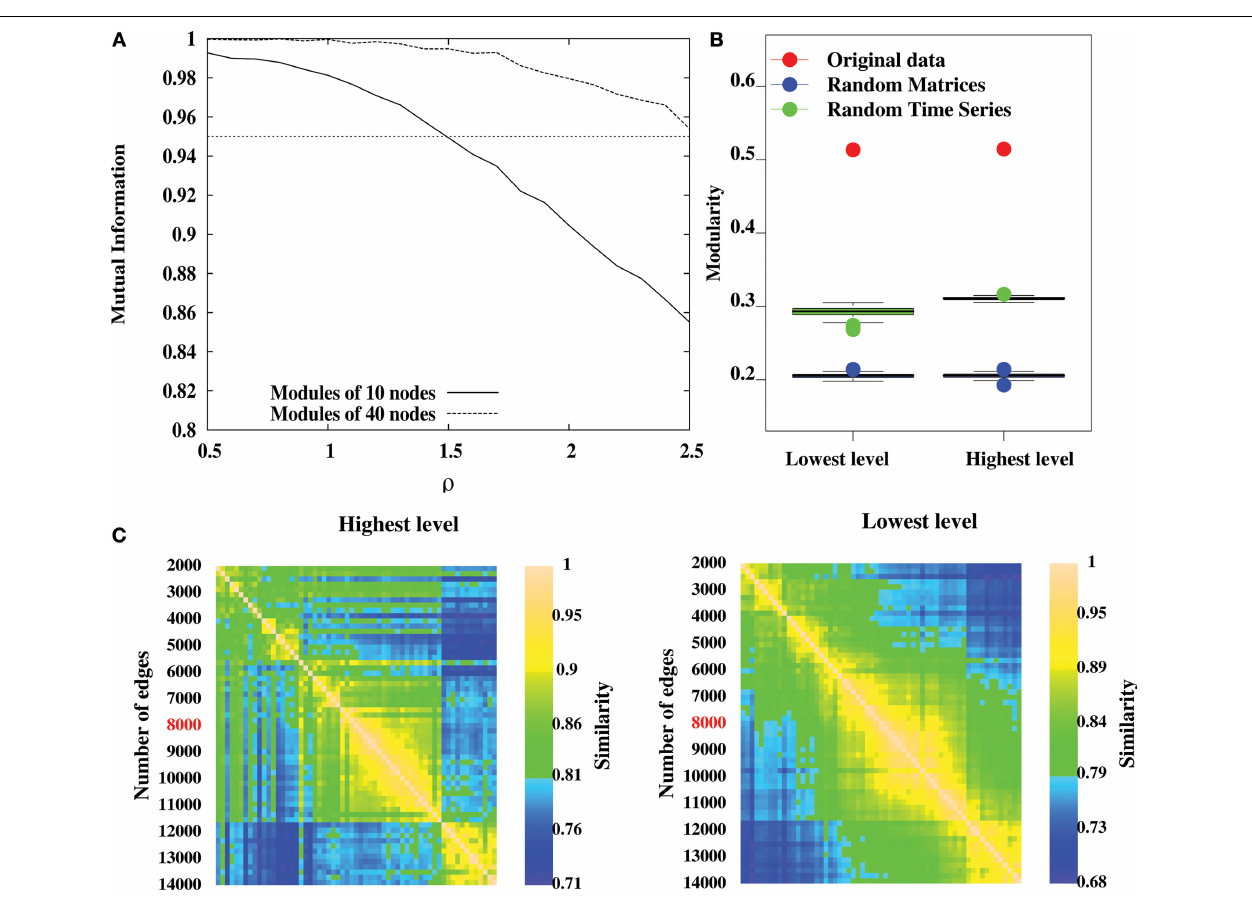
FIGURE 5 | Methodological issues in analysis of hierarchical modularity. (A) Validation of the Louvain method for hierarchical decomposition on a benchmark network defi ned in Sales-Pardo et al. (2007). The network is naturally made of 64, 16 and 4 modules of 10, 40 and 160 nodes respectively. The separability of different levels of the benchmark network is controlled by the parameter ρ . We calculate the normalized information between the lowest non- trivial level partition and the natural partition of 64 modules (solid curve), and between the second level partition and the natural partition of 16 modules (dashed curve). After averaging over 20 different realizations of the network, our